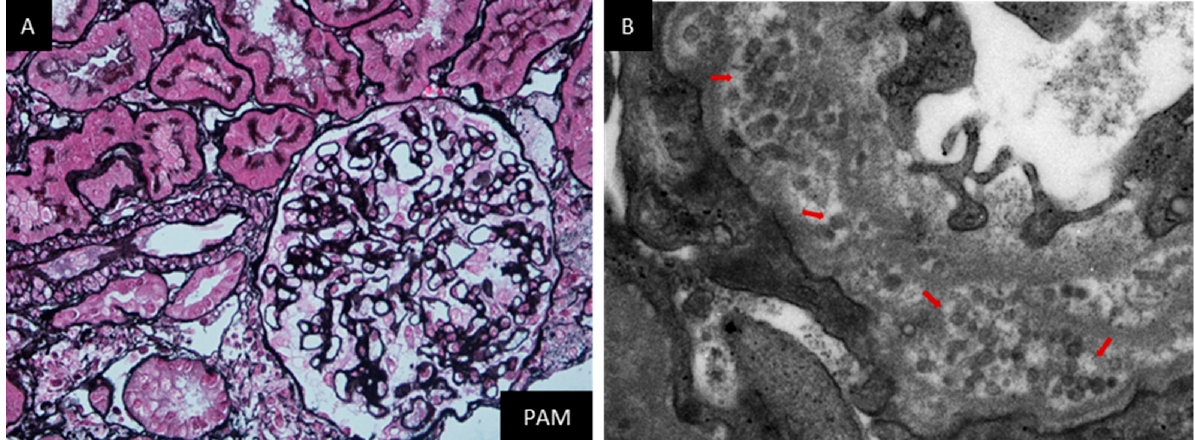
Figure 4. Representative pathological images of renal biopsy specimen form Case 4. Note: Light microscopy showed mild mesangial matrix expansion and mild thickening of GBM (( A ), PASM + Masson, 400×). Electron microscopy showed diffuse podocyte foot process effacement, mild podo- cyte infolding, and prominent microspheres (red arrow) within the GBM (( B ), 50,000×).